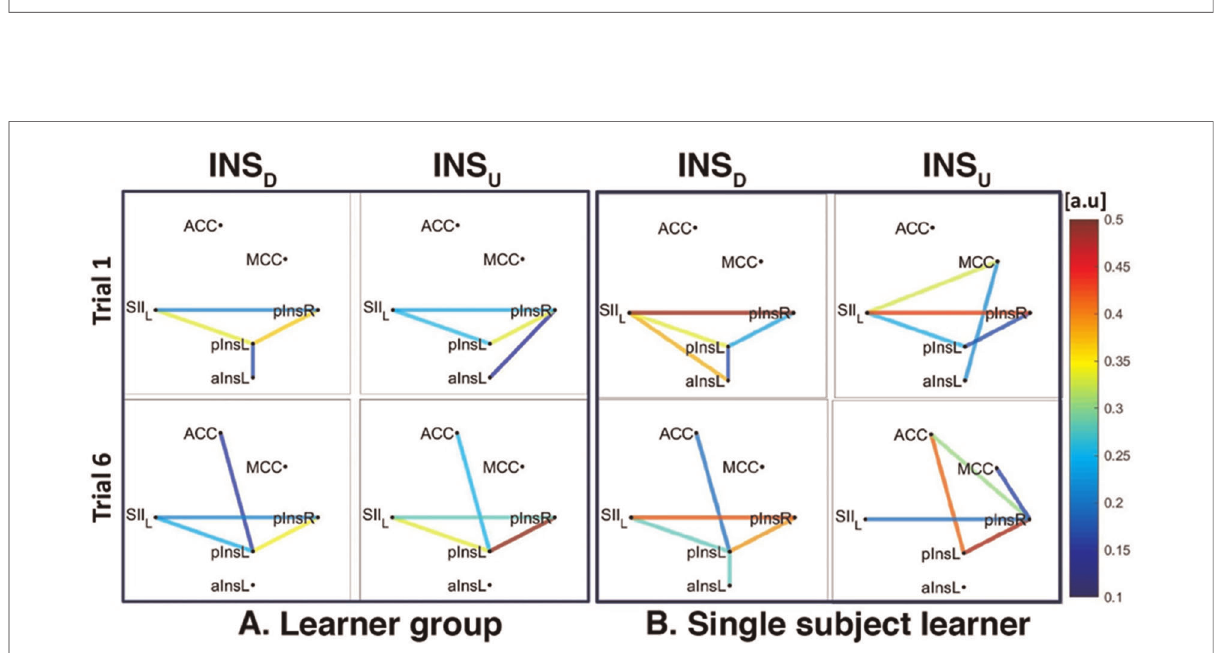
FIGURE 7 Connectivity strengths identi fi ed using the Coherence analysis for the Ins condition in the Learner group ( A ) and for a representative Learner ( B ) in the fi rst trial (Trial 1, top) and in the last trial (Trial 6, bottom). The colors from blue to red indicate weak to strong connection strength respectively and are expressed in arbitrary units